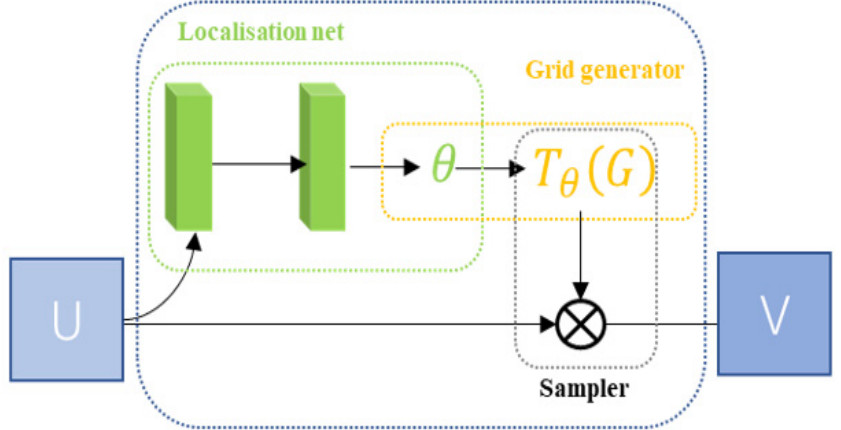
Figure 3. The STN module. Figure 3. The STN